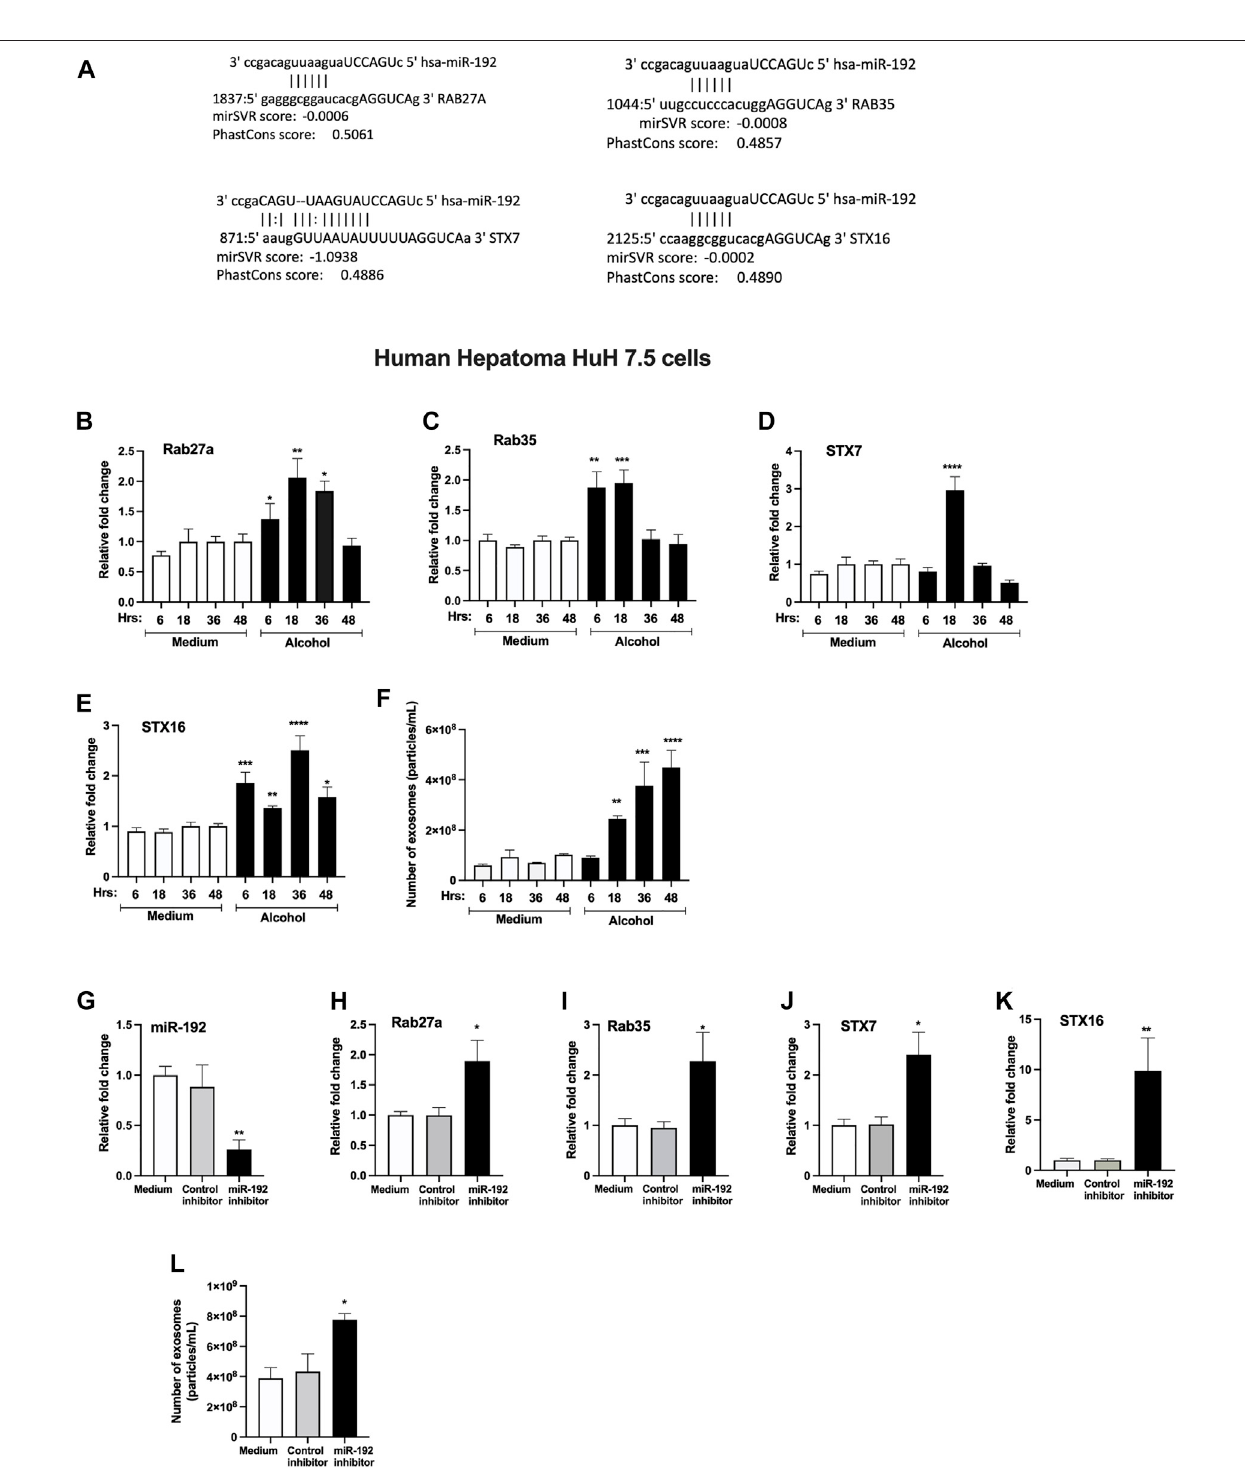
FIGURE4| miRNA-192 regulates exosomesecretion via targetingRabs and syntaxins.miR-192 putative binding sites at the3 ’ UTR ofRab27a,Rab35, STX7 and STX16 genes (A) . Huh 7.5 cells were treated or not with 50 mM alcohol for indicated times and expression of Rab27a (B) , Rab35 (C) , STX7 (D) , and STX16 (E) was quanti fi edfromRNAisolatedfromcellsusingqPCR.Totalnumberofparticleswasmeasuredfromthecellfreesupernatantafter50 mMofalcoholtreatmentforindicated timesusingNanosightandpresentedasparticles/ml (F) .Huh7.5cellsweretransfectedeitherwithnegativecontrol-miRNAormiR-192inhibitorasdescribedinthe methods.miR-192 expression wasmeasured from thecellsusing qPCRand RNU48wasused asanormalizationcontrol (G) .Theexpression ofRab27a (H) , Rab35 (I) , STX7 (J) , and STX16 (K) was determined using qPCR. Total number of particles was evaluated from the cell free supernatant after miR-192 inhibition using Nanosight andpresentedasparticles/ml (L) .18swasusedtonormalizethecqvalues.Datarepresentmean ± SEM.One-wayANOVAorMann-Whitneytestwasusedforstatistical analysis. *, **, ***, ****indicates p < 0.05, p < 0.005, p < 0.0005, p < 0.0001 compared to control cells.